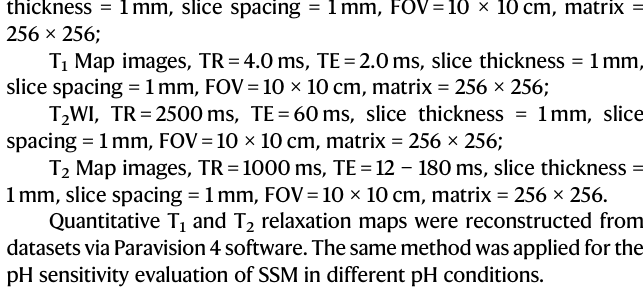
sites beforeand after2h injection of SSM-PEGcontrast agents. Data are presented as mean±SD from three independent mice samples. g H&E stain of tissue slices taken from the muscle in fl ammation sites. Representative data are shown from three mice samples. The two-tailed Student ’ s t -test is employed for the statistical analysis. * P <0.05; ** P <0.01; *** P <0.001. Source data are provided as a Source Data fi